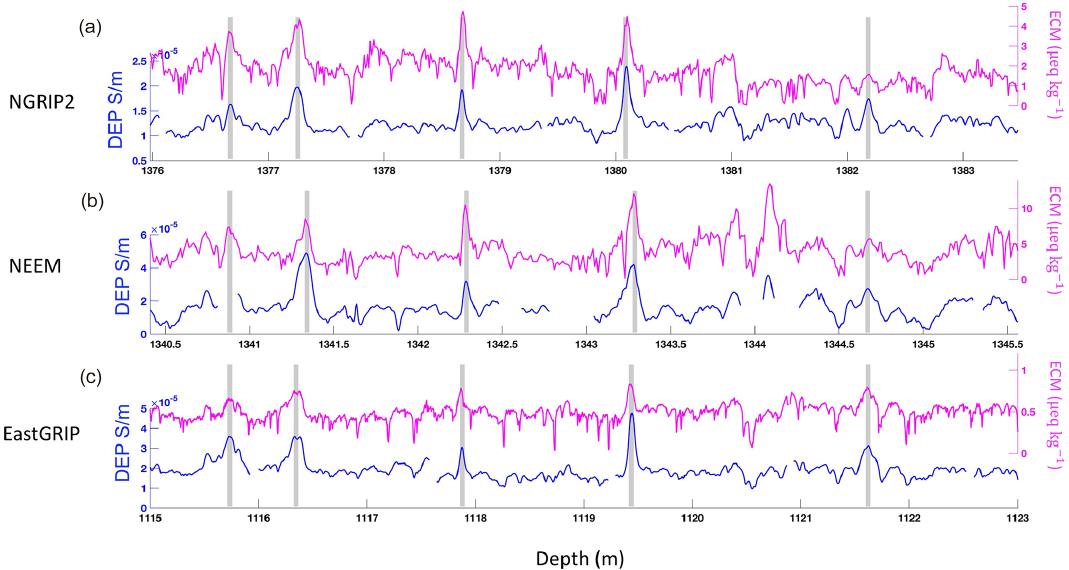
Figure 8. Example of the ECM and DEP data match between the NGRIP2 (a) , NEEM (b) and EGRIP (c) cores. The match points are marked by grey